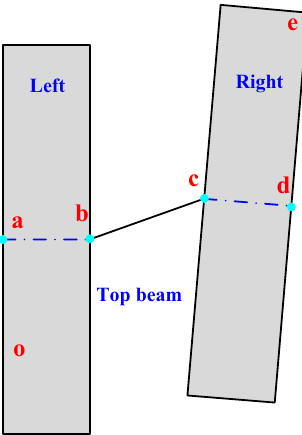
Figure 9. 2D model diagram of offset between leading hydraulic supports.